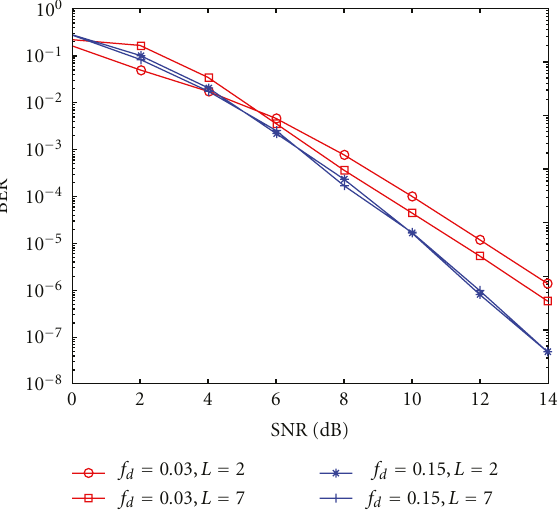
Figure 8: BER comparison of OFDM